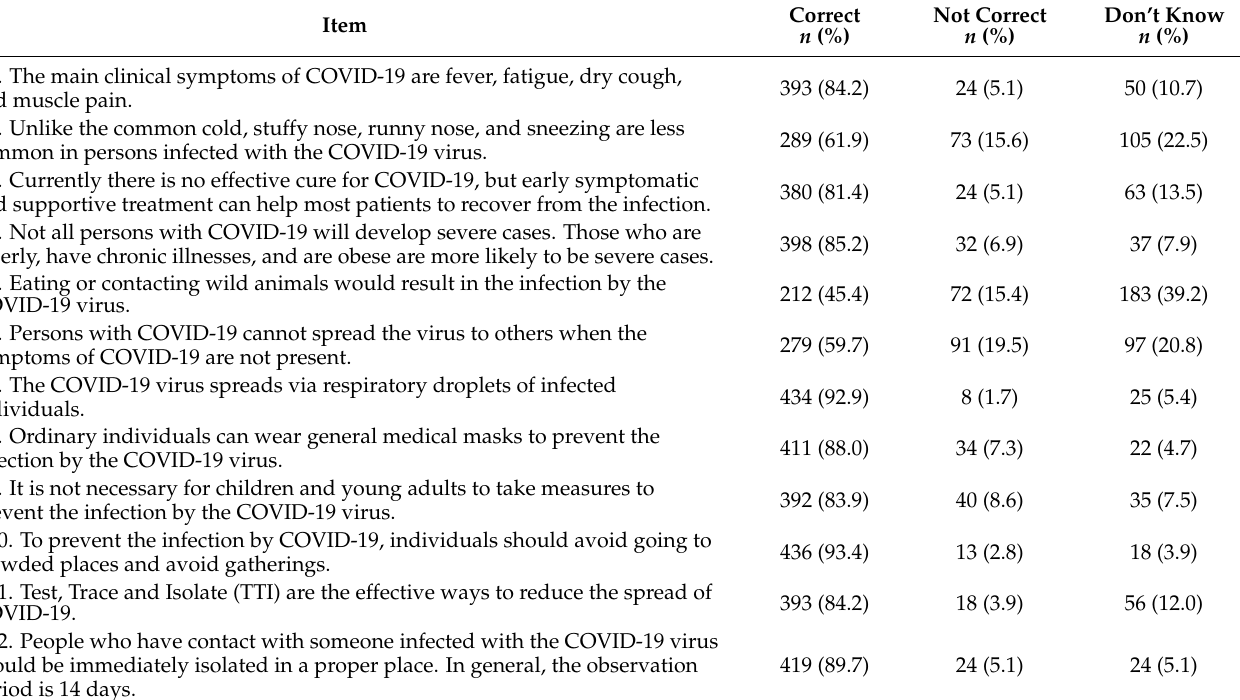
Table 2. Responses to Knowledge Questions ( n =